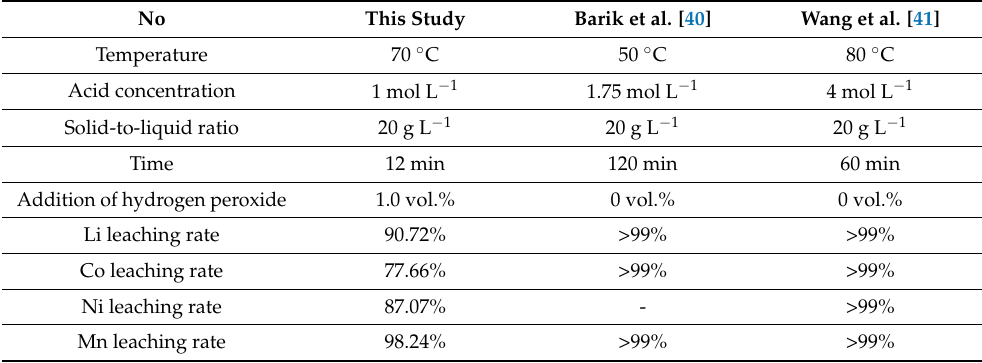
Table 4. Comparison of hydrochloric acid leaching